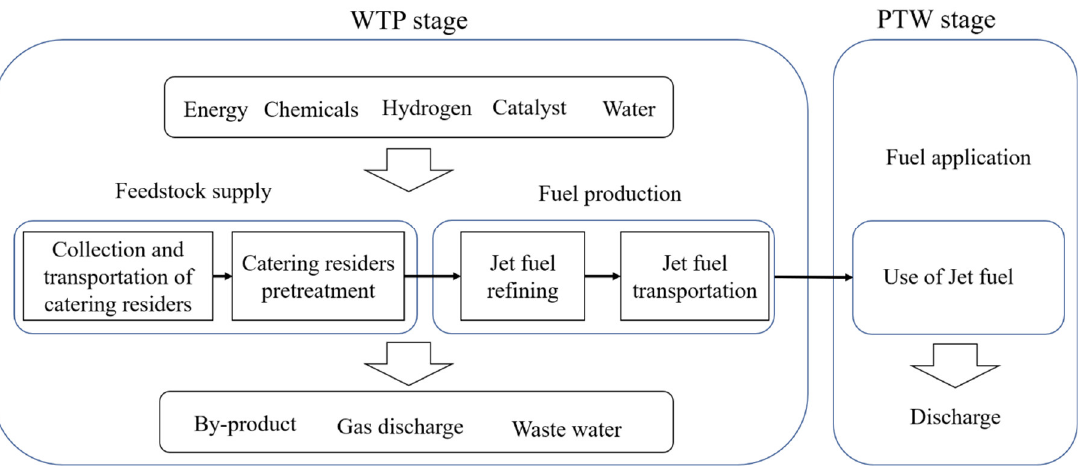
Figure 1. Life-cycle system boundary of WCO for bio-jet fuel.